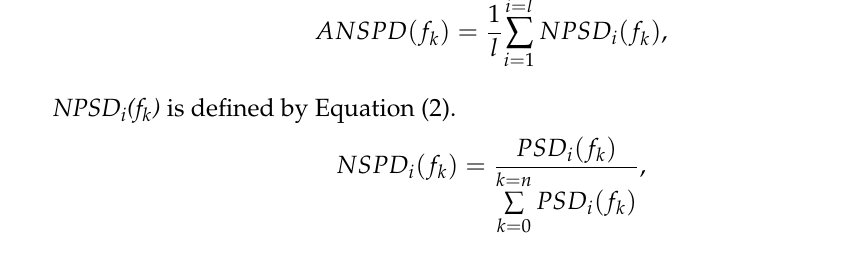
Figure 10. Exemplary acceleration time histories acquired by the wireless sensors possibly triggered by a heavy vehicle transiting on the upper